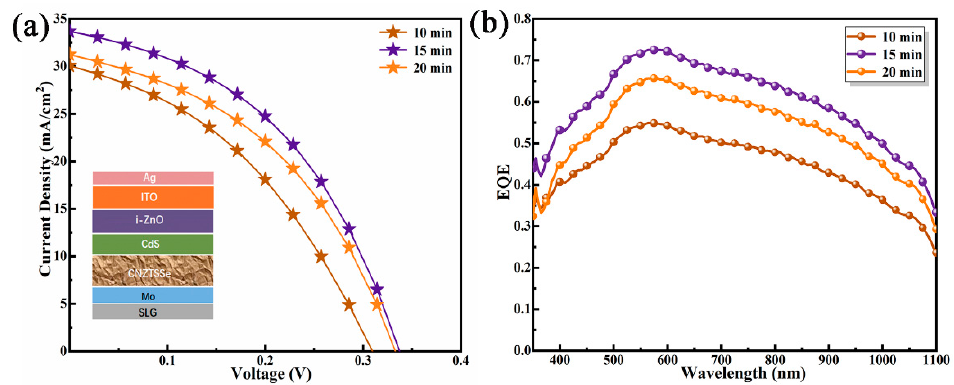
Figure 9. ( a ) J ‐ V characteristic curves of CNZTSSe solar cells at the selenidation time of 10, 15, and 20 min. ( b ) Corresponding EQE curves of CNZTSSe solar cells.